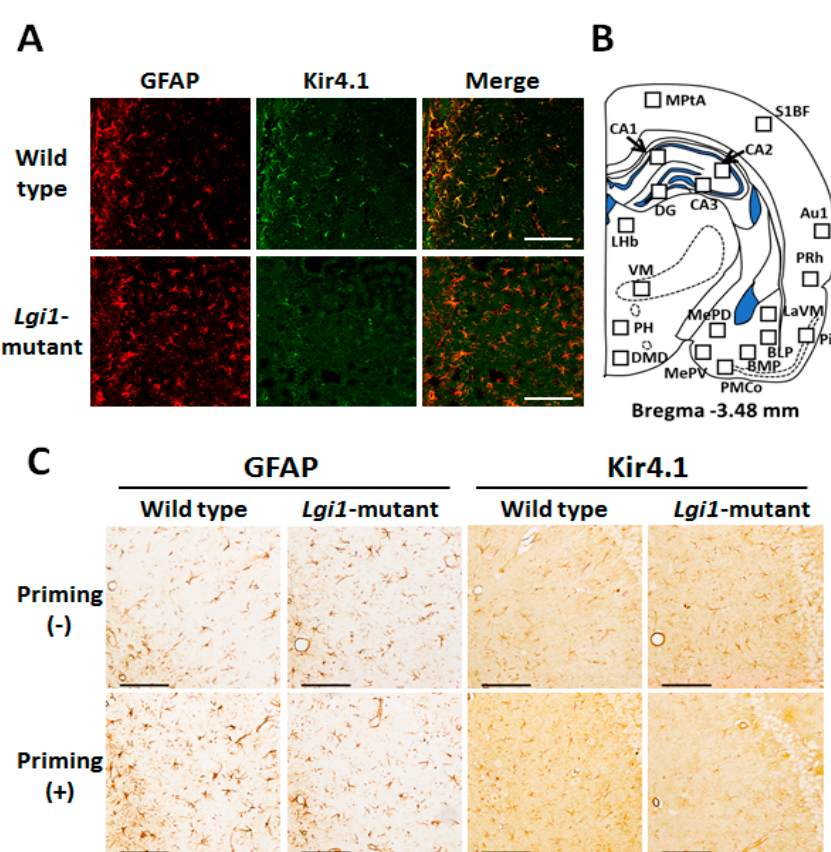
Figure 2. Kir4.1 expression in astrocytes. ( A ) Representative images of immunofluorescence double staining for glial fibrillary acidic protein (GFAP) and Kir4.1 in the hippocampal CA1 region in wild-type F344 rats (top panels) and Lgi1 mutant rats (bottom panels). Scale bar: 100 µ m. ( B ) Schematic illustration of a brain section (Bregma − 3.48 mm level) selected for quantitative analysis of immunoreactivity (IR) of Kir4.1 or GFAP. Squares in each brain region indicate the areas analyzed for counting of Kir4.1-IR-positive or GFAP-IR-positive cells. Medial parietal association cortex (MPtA), primary somatosensory cortex barrel field (S1BF), primary auditory cortex (Au1), perirhinal cortex (PRh), piriform cortex (Pir), hippocampal CA1, CA2, CA3, and dentate gyrus (DG), medial amygdaloid nucleus posteroventral part (MePV), medial amygdaloid nucleus posterodorsal part (MePD), posteromedial cortical amygdaloid nucleus (PMCo), basomedial amygdaloid nucleus posterior part (BMP), basolateral amygdaloid nucleus posterior part (BLP), lateral amygdaloid nucleus ventromedial part (LaVM), lateral habenula (LHb), ventromedial thalamus (VM), posterior hypothalamus (PH), dorsomedial hypothalamic nucleus, and dorsal part (DMD). ( C ) Representative images of immunohistochemical staining for GFAP and Kir4.1 in the hippocampal CA1 regions of non-primed wild type rats (upper left panels), primed wild type rats (lower left panels), non-primed Lgi1 mutant rats (upper right panels), and primed Lgi1 mutant rats (lower right panels) after audiogenic seizure induction. Scale bar: 100 μ m.